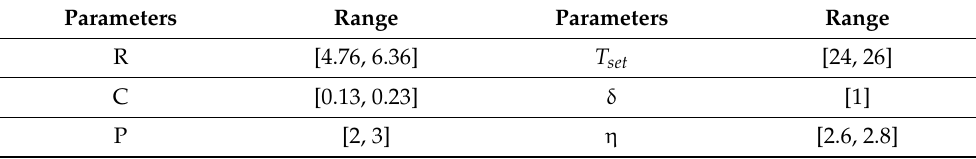
Table 2. Load parameter range of fixed-frequency air-conditioning.